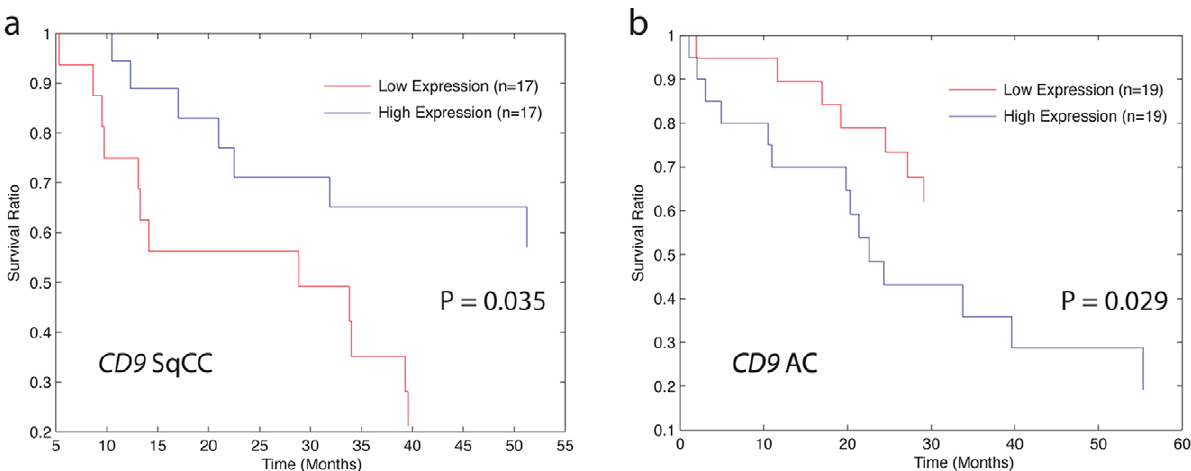
Figure 9. SqCC cell lines are more sensitive to the HDAC inhibitor Trichostatin A than AC cell lines. a) Dose-response analysis of Trichostatin A on the relative viability of three AC (A549, H3255 and H1395) and three SqCC (H520, HCC15 and HCC15) cell lines. Each curve was generated from the average data points from four separate experiments. b) Table with the average IC 50 and SEM for each cell line tested derived from four separate experiments.